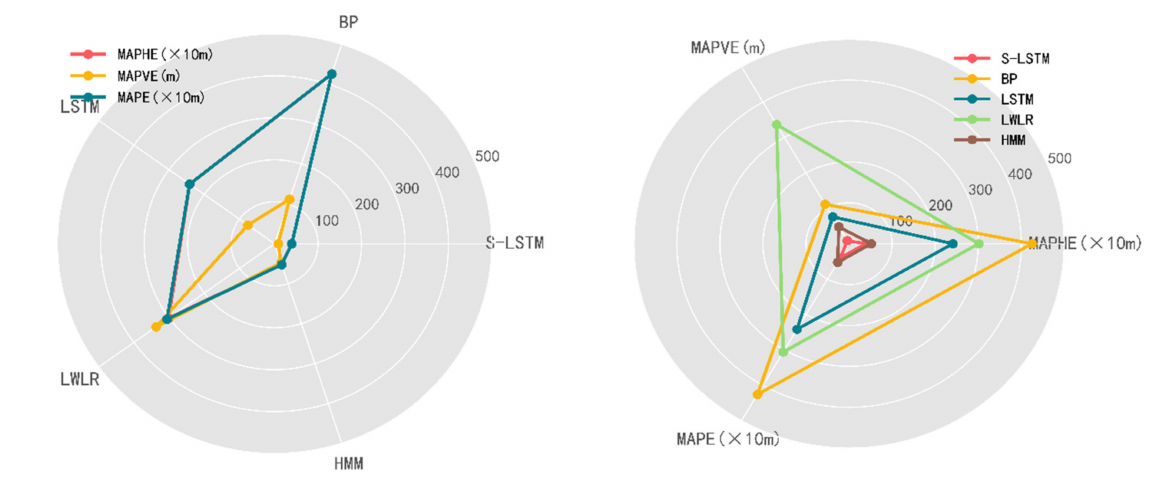
Figure 8. Radar chart of predicting errors for arrival flights.